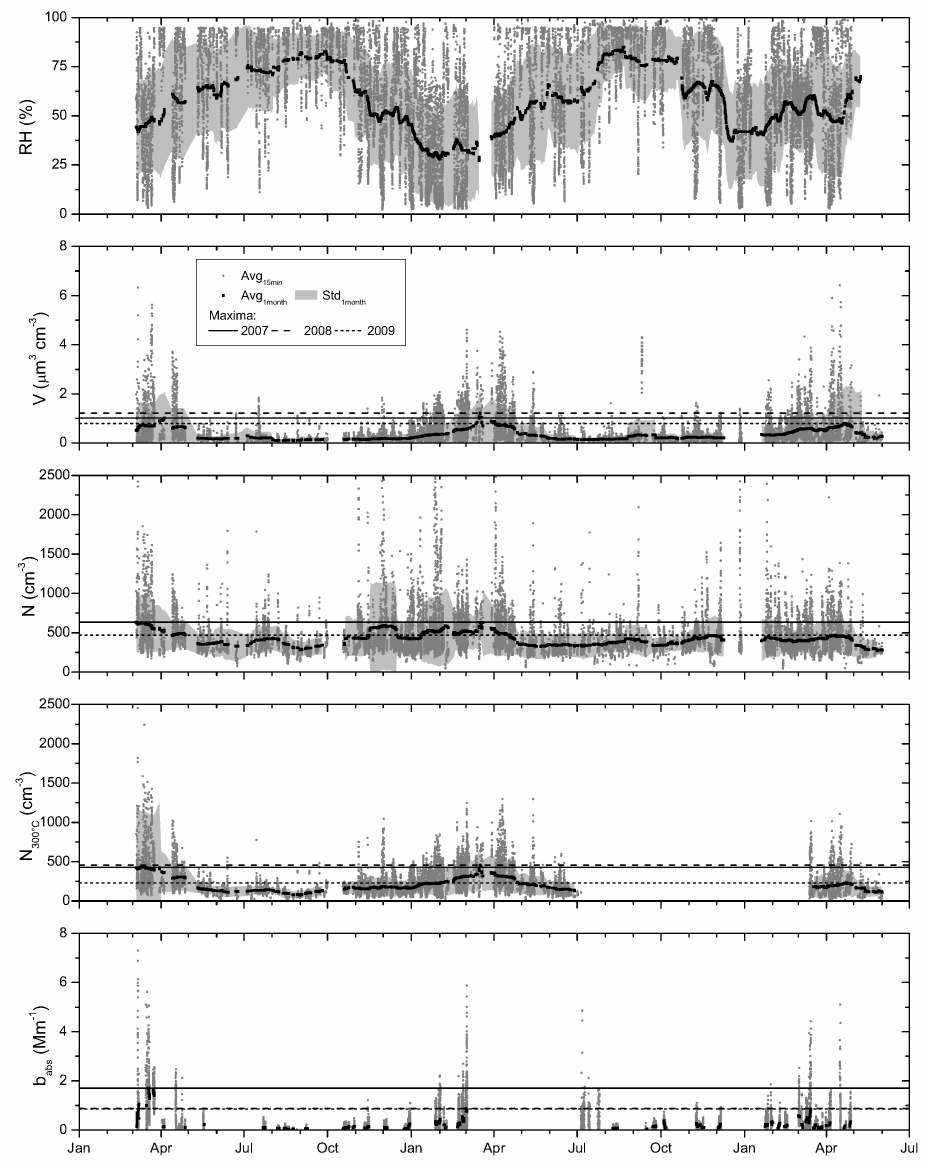
Fig. 2. Time series of data observed in the LFT comprising relative humidity RH (%), ambient particle volume concentration V ( D p = 10– 470nm) (µm 3 cm − 3 ), ambient aerosol number concentration N (cm − 3 ), refractory particle number concentration N 300 ◦ C (cm − 3 ), and absorption coefficient b abs (Mm − 1 ). The small dots in dark grey indicate 15min averages, the black squares the one monthly adjacent average and its standard deviation in light grey. Horizontal lines show the maxima of the one monthly adjacent average for each dry